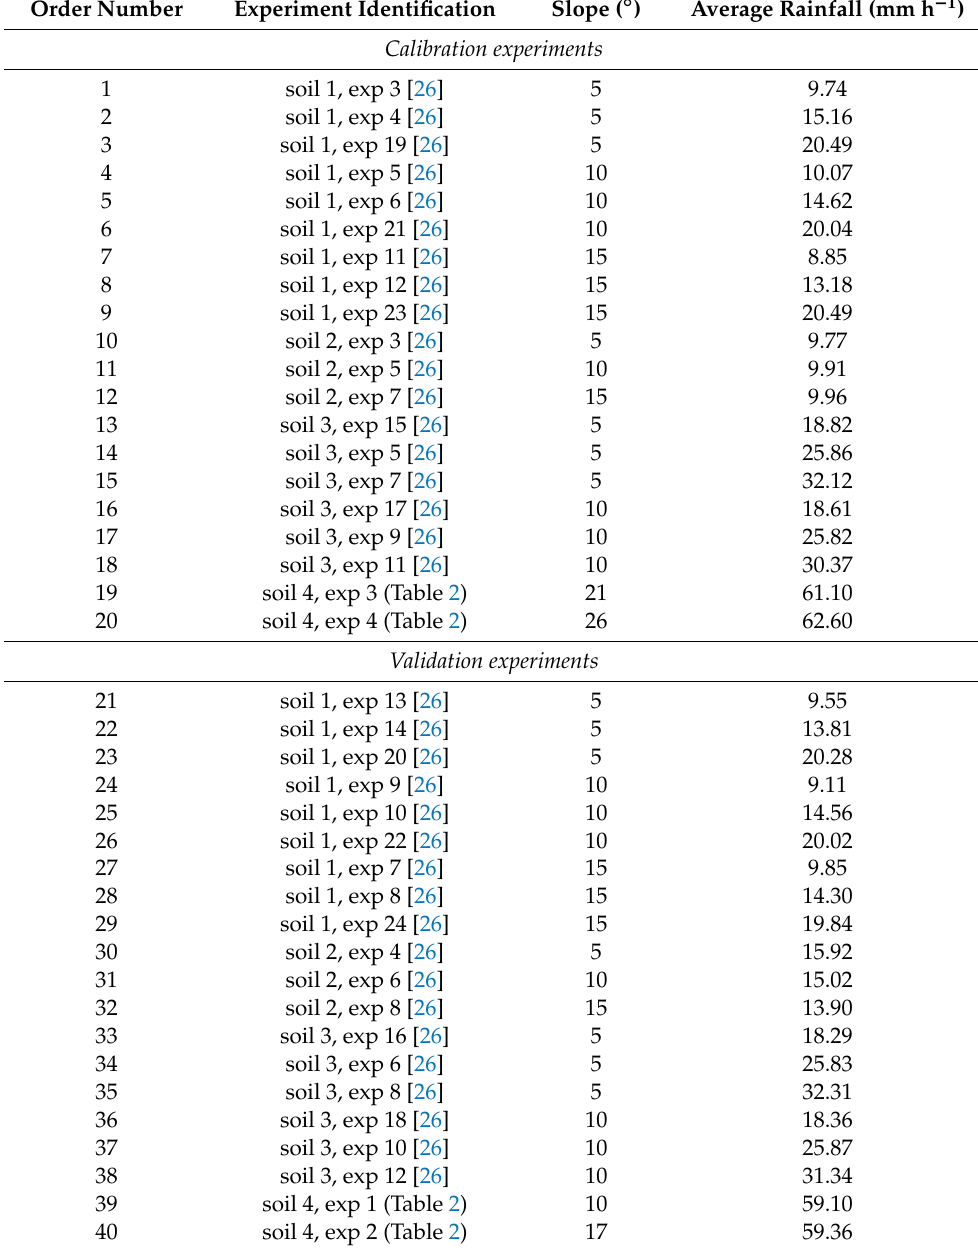
Table 3. Main characteristics of the selected laboratory experiments (from Reference [26] and Table 2), subdivided into calibration and validation